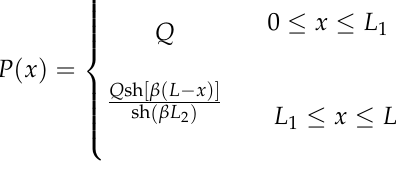
Figure 2. Analytical model of the full-length bonded prestressed bolts. ( a ) full-length bonded pre- stressed bolt; ( b ) end-anchored prestressed bolt; ( c ) full-length bonded unprestressed bolt.